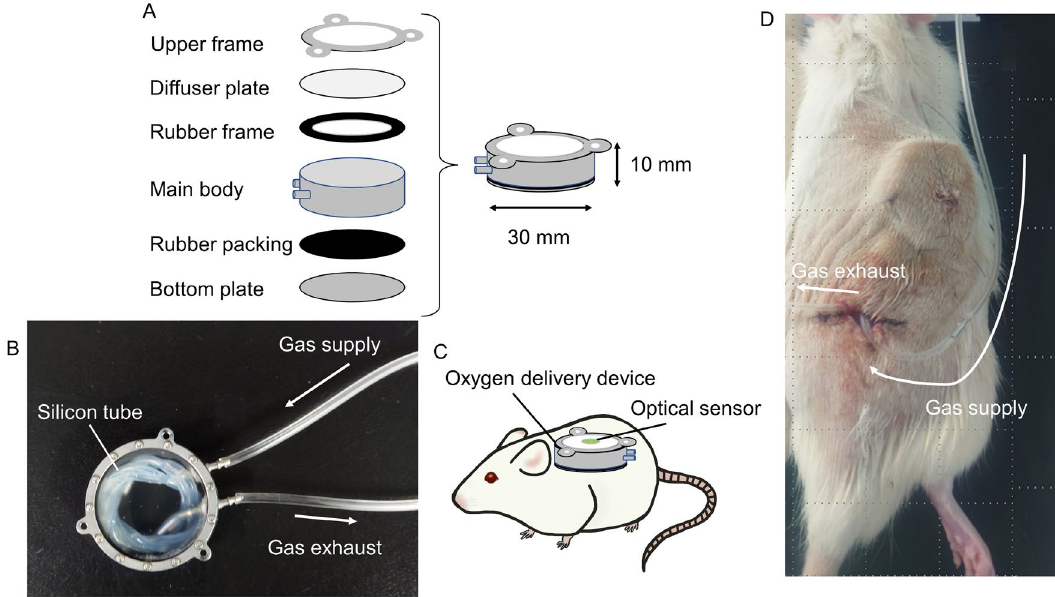
Figure 3. The oxygen delivery device and oxygenation procedure. ( A ) Overview of the components of the oxygen delivery device. The main body was filled with F6H8S5, and the oxygen contained in the F6H8S5 gradually diffused to the surrounding space. ( B ) Photograph of the oxygen delivery device. A silicon tube was connected to the cannulas inside the main body, and pure oxygen or ambient air was supplied to the device by a connecting tube outside the cannula (arrows) to oxygenate the F6H8S5. ( C ) Image of post-implantation of the oxygen delivery device for continuous measurement of pO 2 at the subcutaneous space. An optical sensor was attached to the upper diffuser plate with silicone adhesive. ( D ) Oxygenation of the SC in rats. The oxygen delivery device was oxygenated after implantation into the SC. The gas was supplied through the tube (arrows) to oxygenate the implanted device.